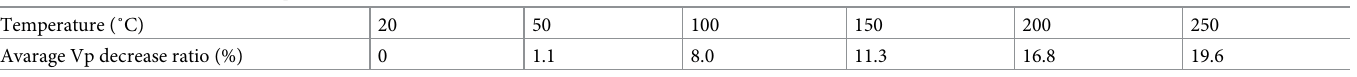
Table 4. The decreasing rates of V p with